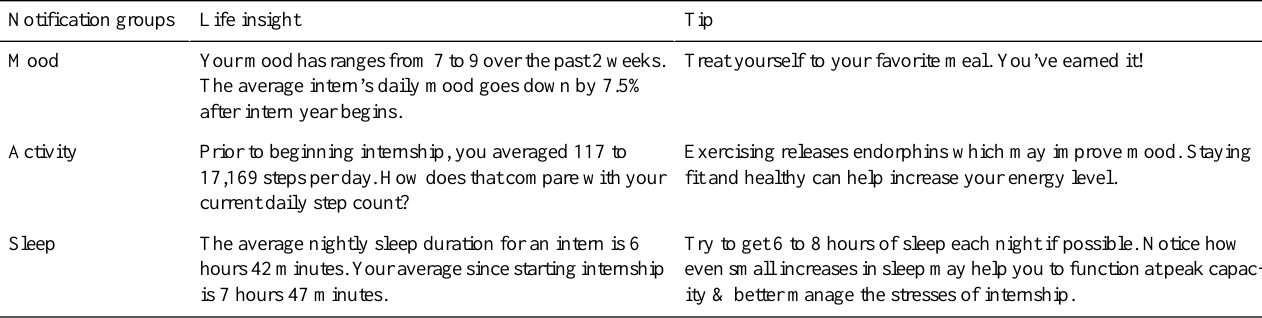
Table 1. Examples of 6 different groups of